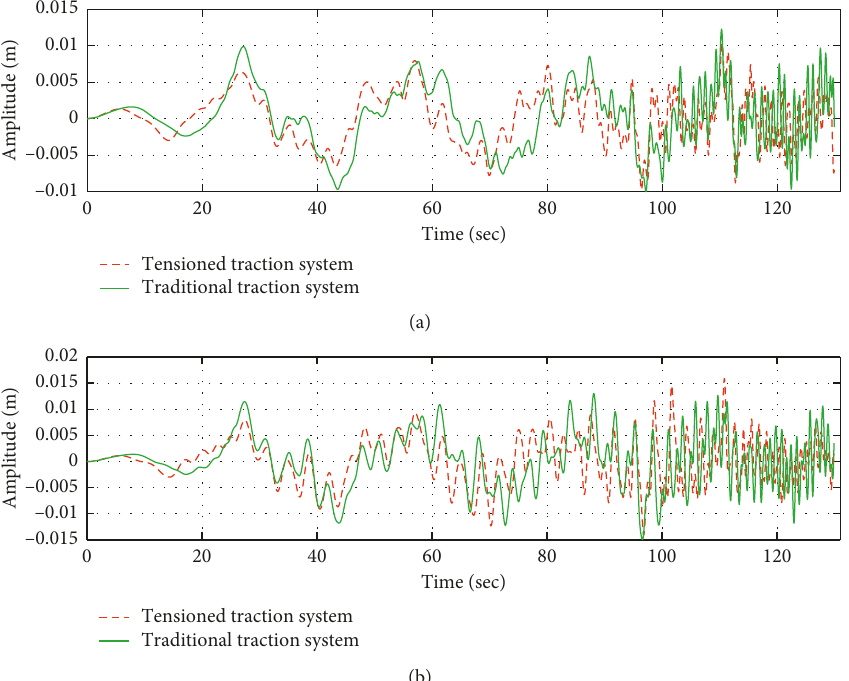
Figure 29: Comparison of the transverse vibration displacements of the connecting points in a tensioned traction system and traditional ; (b) connecting point C traction system; (a) connecting point C 1 2